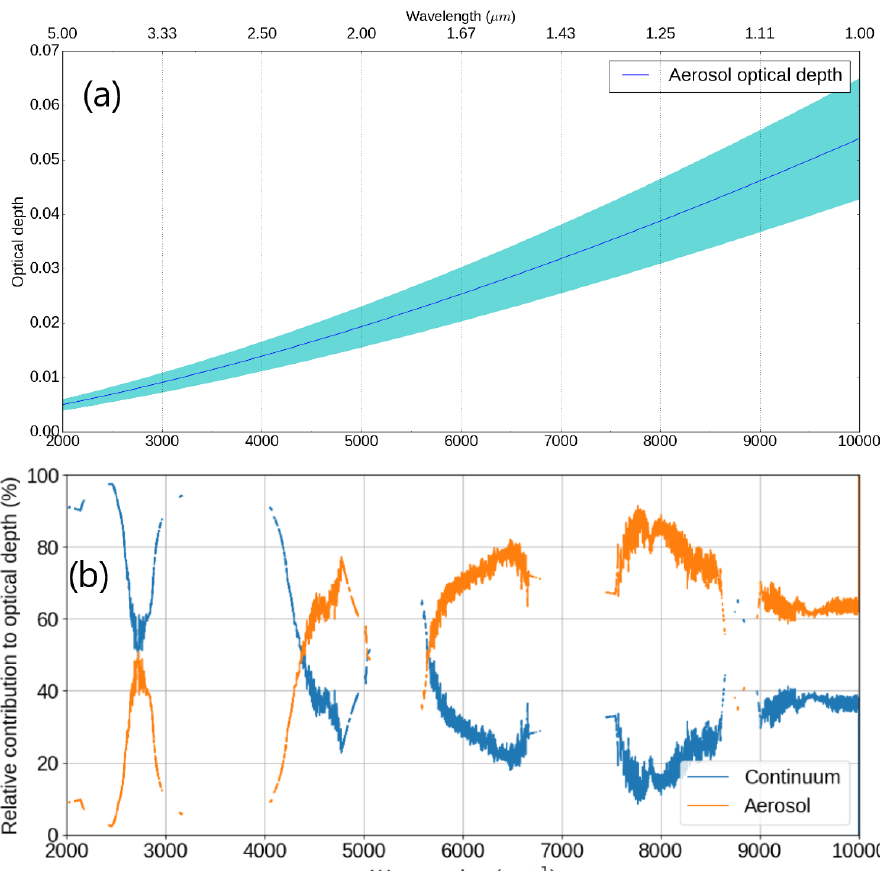
Figure 5. (a) Aerosol optical depth obtained from the Mie scattering calculations for 18 September 2008 with the Microtops τ aerosol at 1µm, along with the estimated k = 1 uncertainties (shaded region). (b) Relative contribution of the continuum and aerosol in each of the near-infrared windows to the combination of the two ( τ aerosol + τ continuum ).